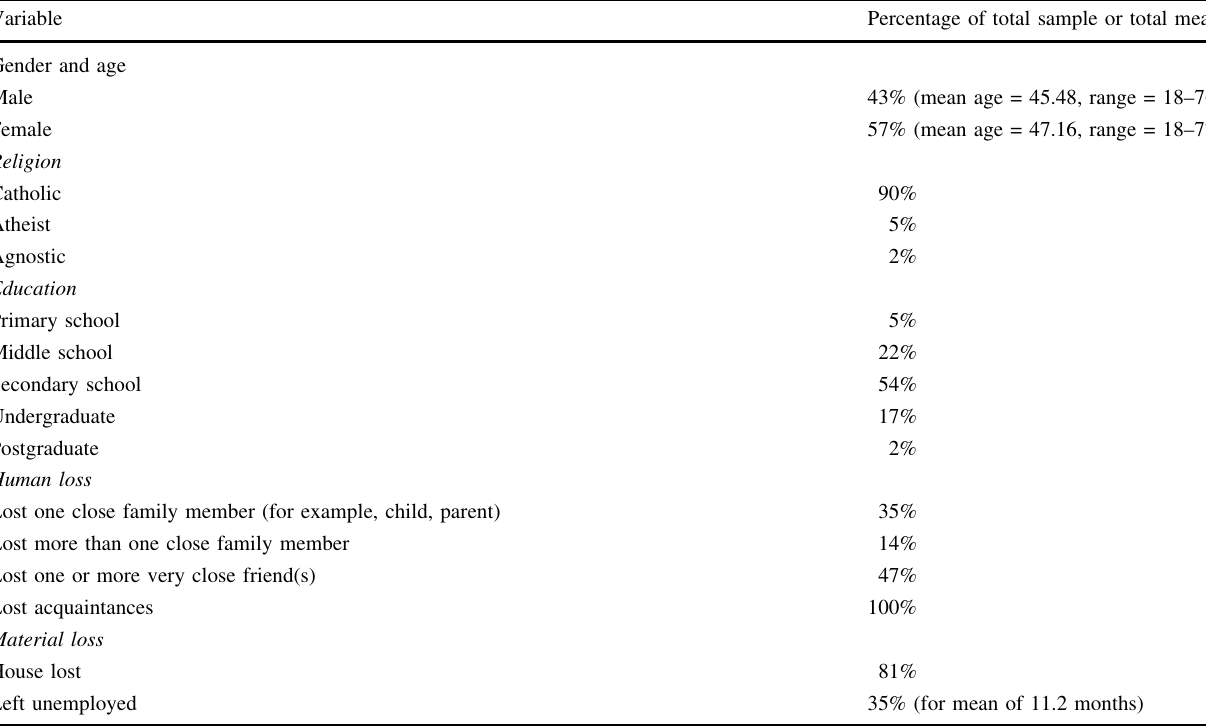
Table 2 Demographic characteristics of the study sample ( N = 112) that participated in both research periods in Amatrice, Central Italy, after the 2016–2017 earthquakes